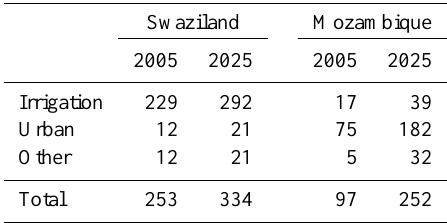
Figure 2 Simplified Umbeluzi River basin system model schematic